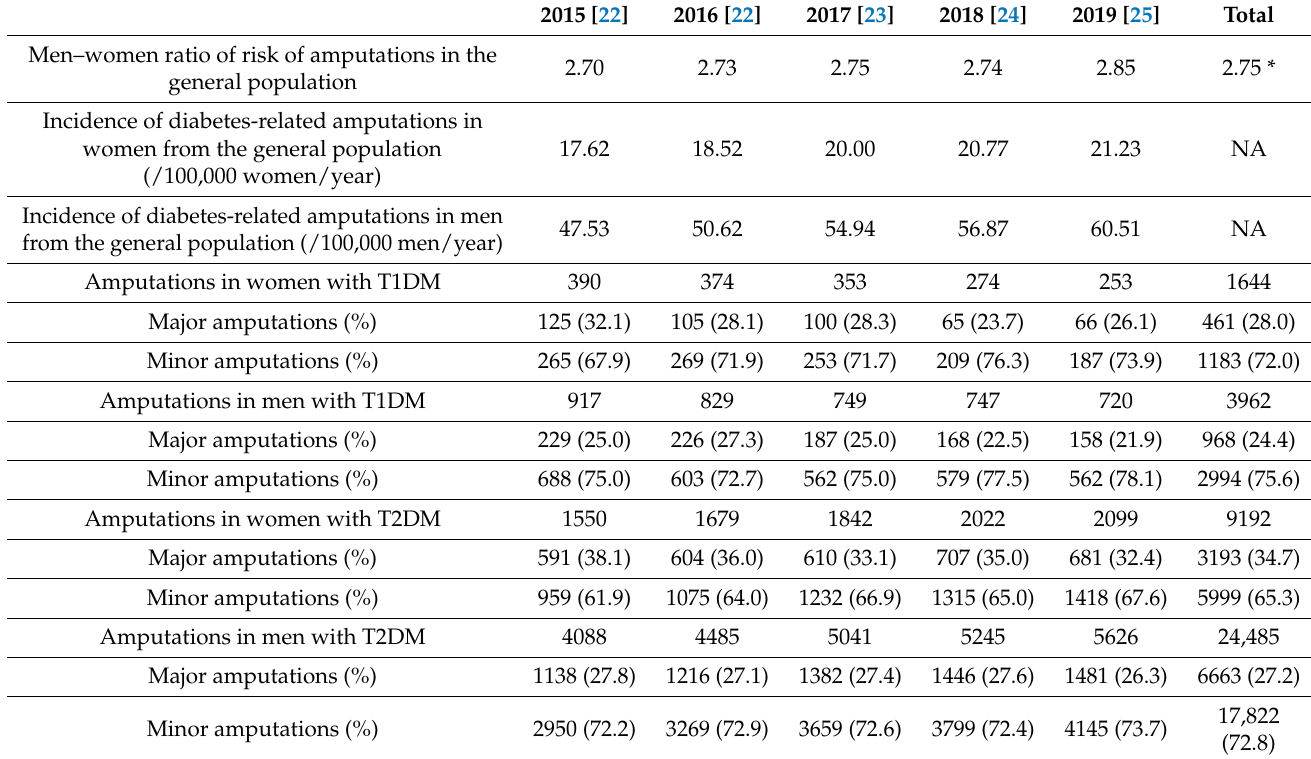
Table 2. Absolute number, crude incidence and level of amputations according to year, type of diabetes and